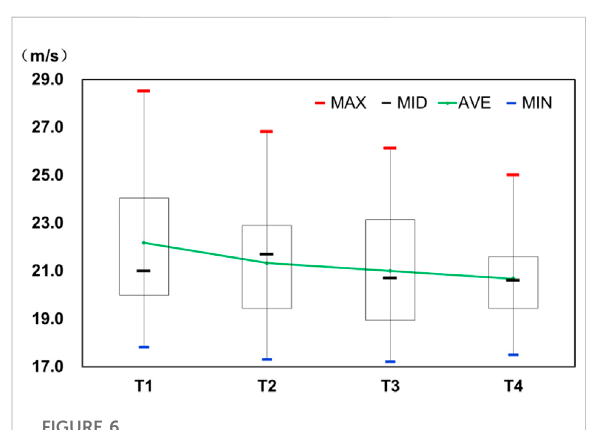
FIGURE 6 Box plot of the daily maximum velocity in T1, T2, T3, and T4.